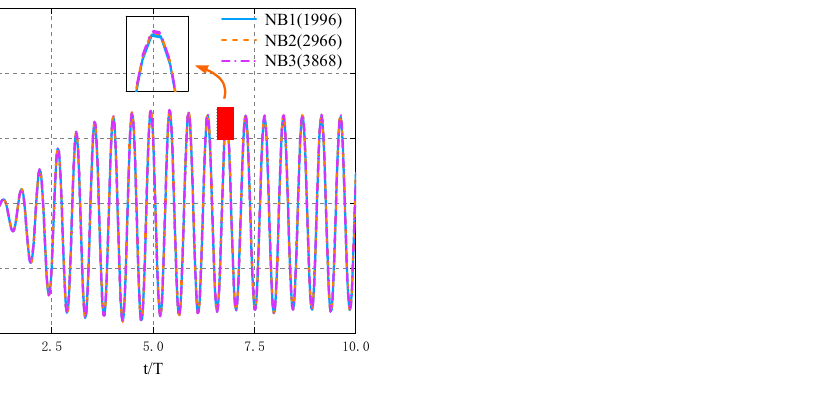
Figure 7. Time history diagram of the surge wave drift force of the KVLCC2 ship under different panel numbers of the full-body surface.